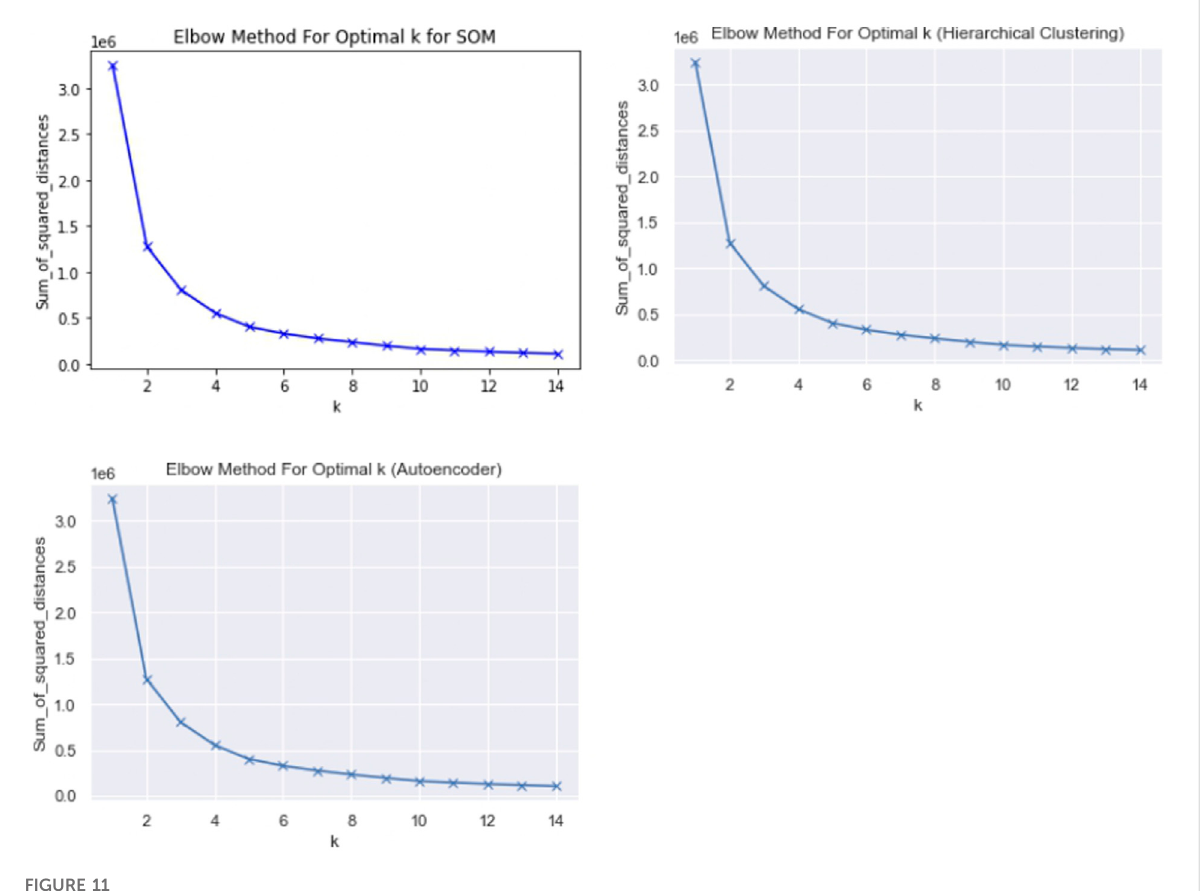
FIGURE 11 Optimal k using Elbow